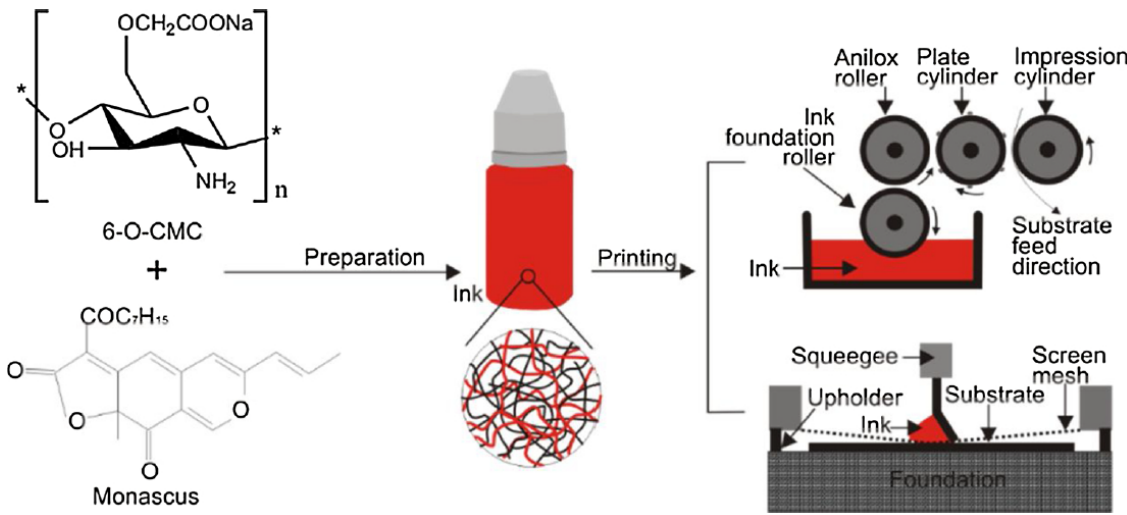
Figure 14. The preparation and printing of carboxymethyl chitosan-monascus based inks (taken from [25]).